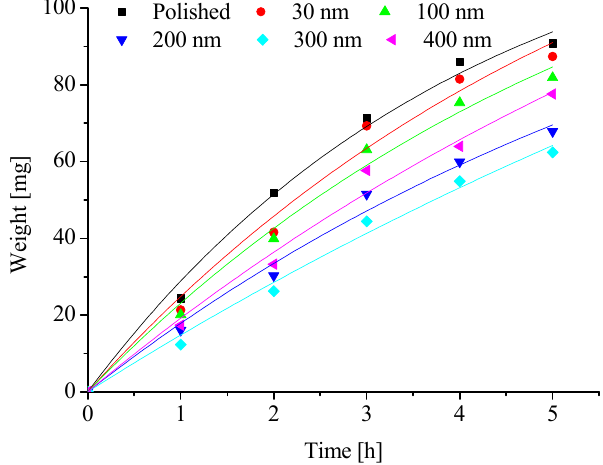
Figure 25. Testing value exponential model regression fitting at T = − 20 °C, φ = 90%.